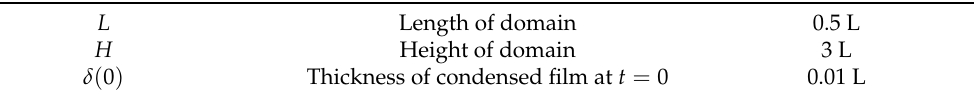
Table 5. The geometric parameters utilized in the vertical condensation benchmark are shown in the table below. All of the dimensions are shown as functions of the length of the domain. The reader will refer to Figure 8 in order to have a better understanding of this table. L Length of domain 0.5 L H Height of domain 3 L δ ( 0 ) Thickness of condensed film at t = 0 0.01